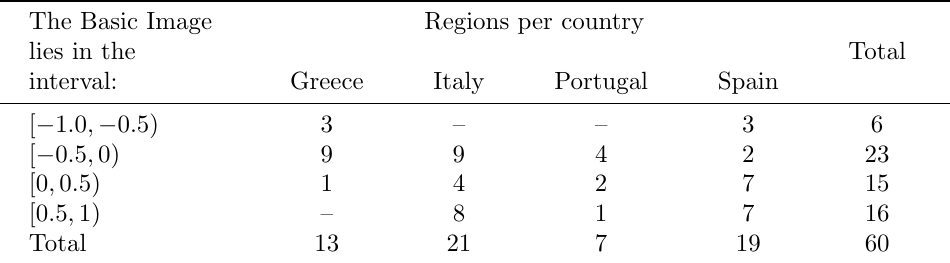
Table 5: Classification of the south European regions according to their Basic Image value The Basic